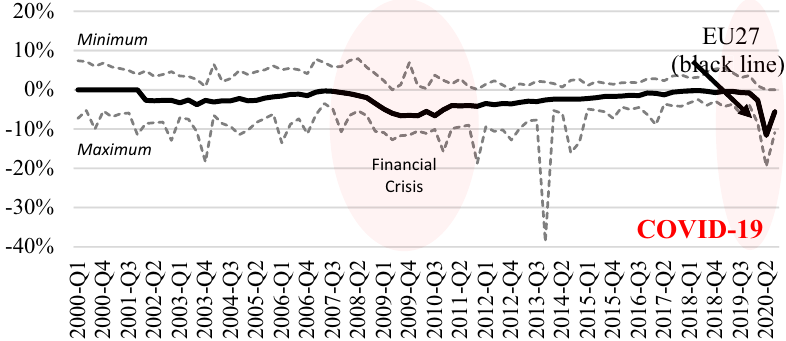
Figure 3: Budgetary de fi cit ( % from GDP ) evolution by quarter ( 2000 – 2020 ) . Source: Authors ’ elaboration based on data from Eurostat. Legend: Maximum – maximum value recorded within EU countries. Minimum – minimum value recorded within EU countries. EU 27 – average at EU 27 level.